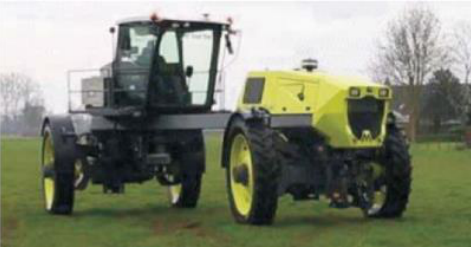
Fig. 37. Muli Tool Trac [16]